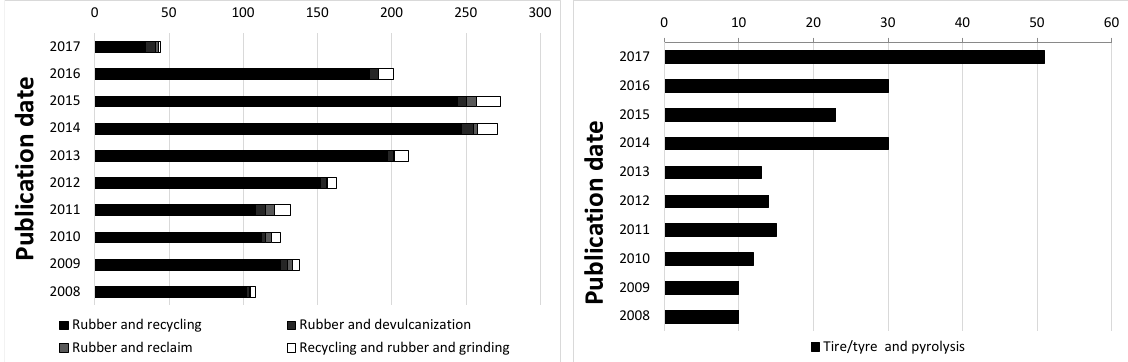
Figure 1. Number of patents on recycling of rubber. Countings according to